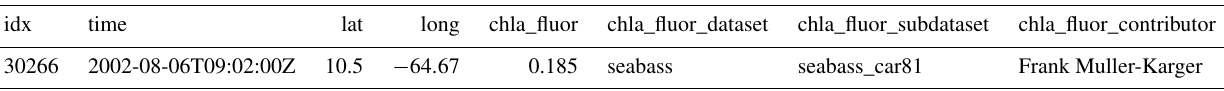
Table B1. Example of how the compiled data look. The result if the compilation is queried for the chlorophyll data from subdataset seabass_car81 is